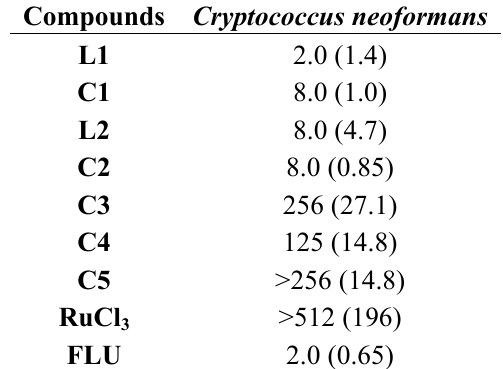
Table 6. In vitro susceptibility of clinical isolates of Sporotrix schenckii for pentakis- dithiocarbamate diruthenium ( C1 – C5 ) complexes by microdilution methods—MIC: μ g mL − 1 (10 − 5 mol L − 1 ).